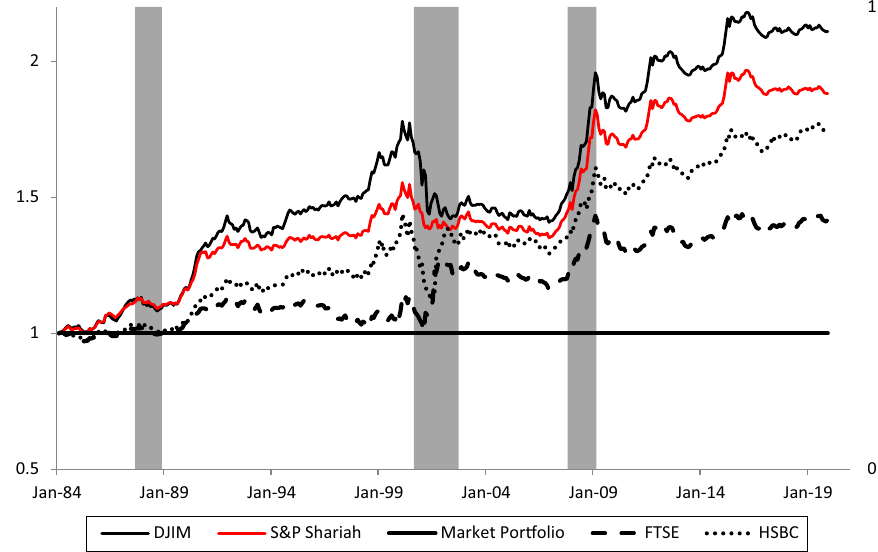
Figure 2. Relative